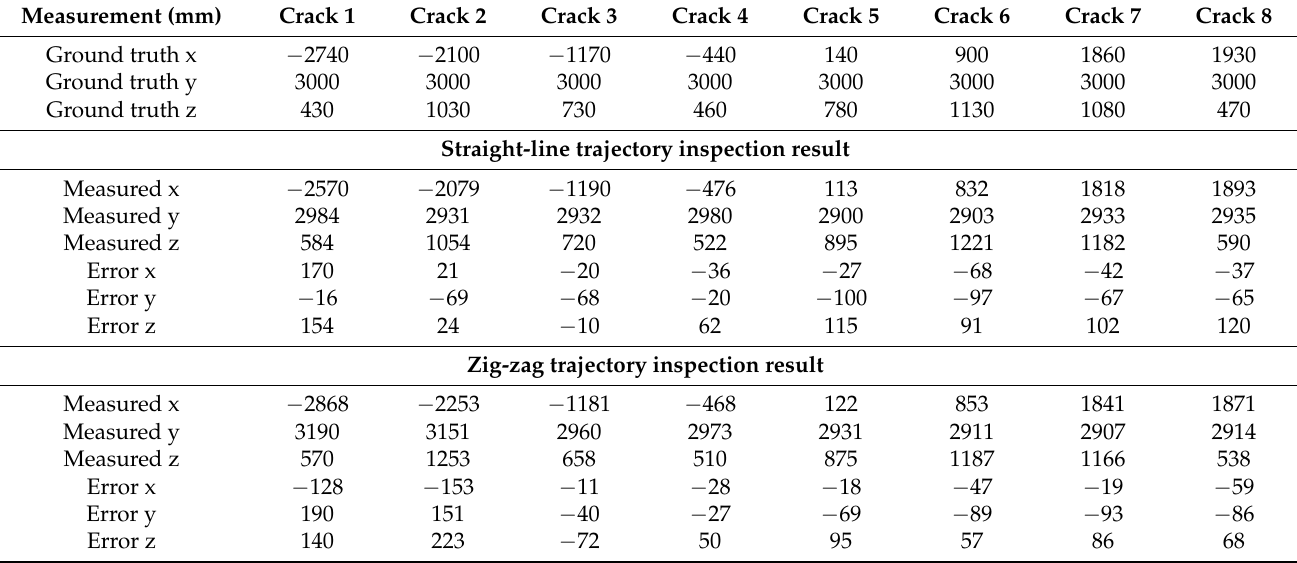
Table 6. The comparison between ground-truth positions and measured positions on the training